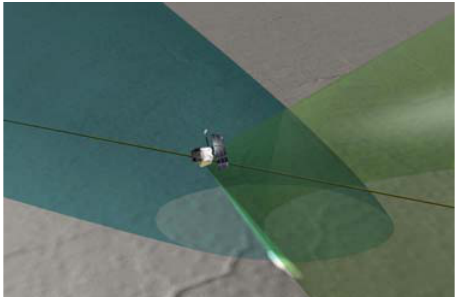
Figure 2b. Geometry of bistatic radar observation. “Range” is the total distance from transmitter (on Earth) to ground to spacecraft so defines an elongated ellipsoid (blue). Doppler shift involves both transmitter and receiver motion but still defines a cone